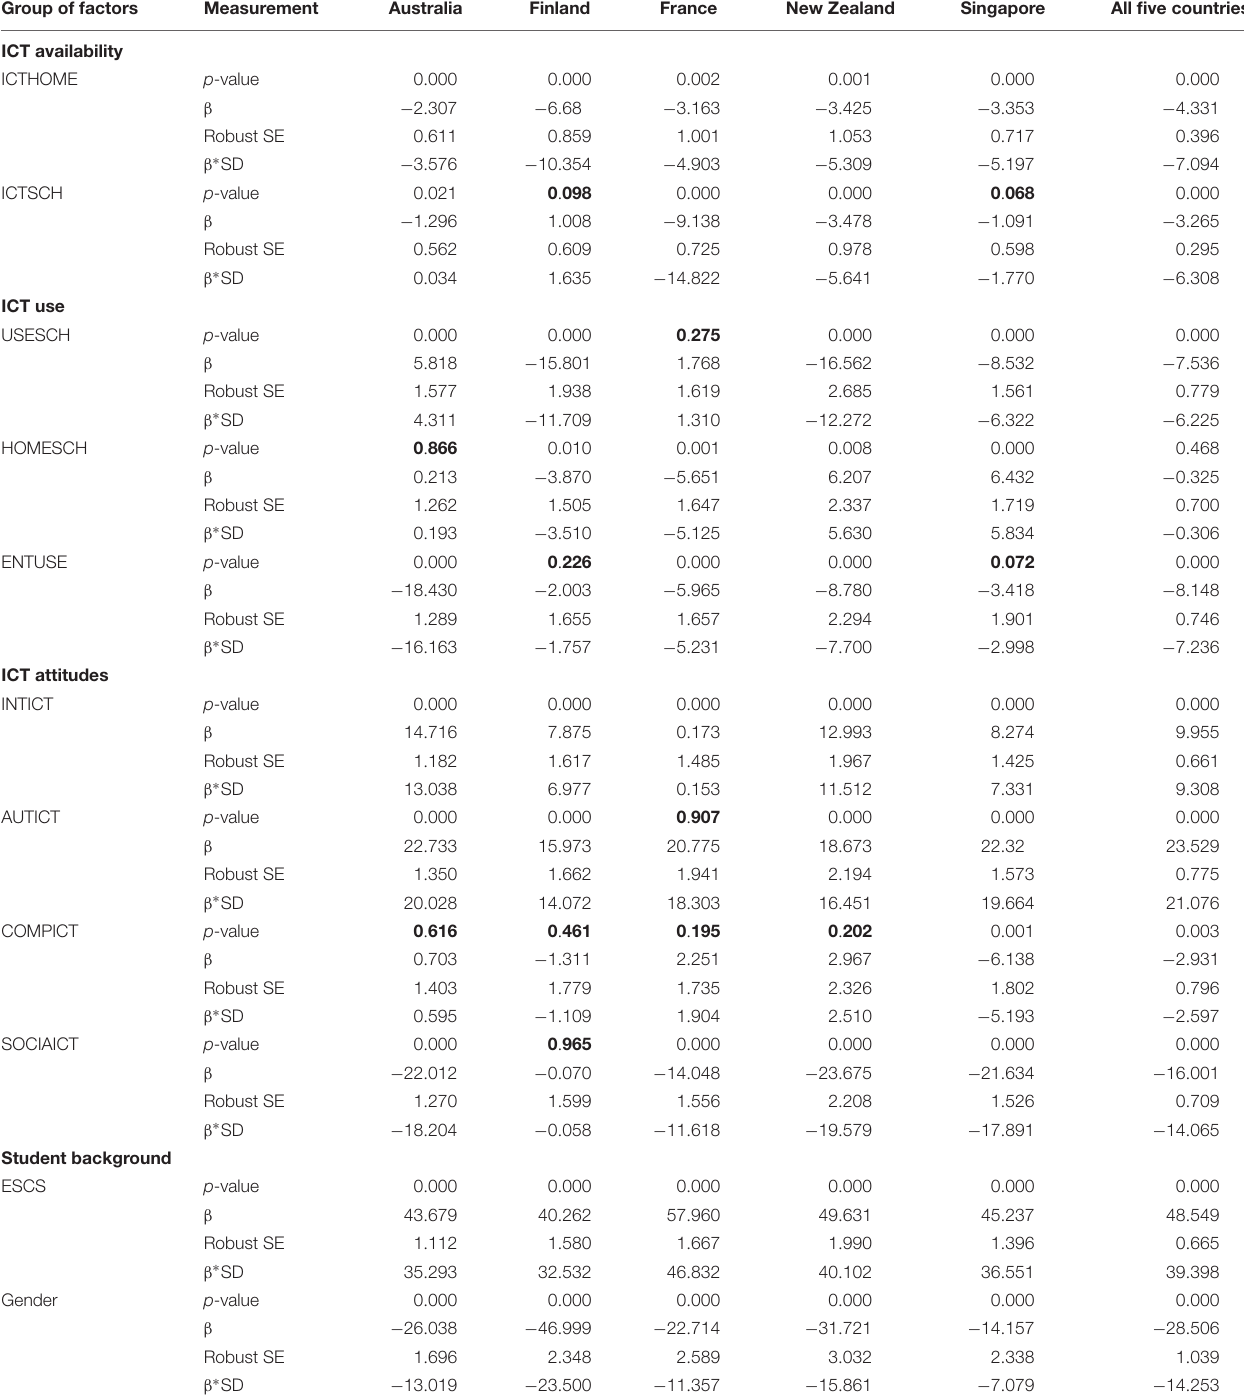
TABLE 6 | The effect of ICT impact factors on reading proficiency in each of the five countries. Group of factors